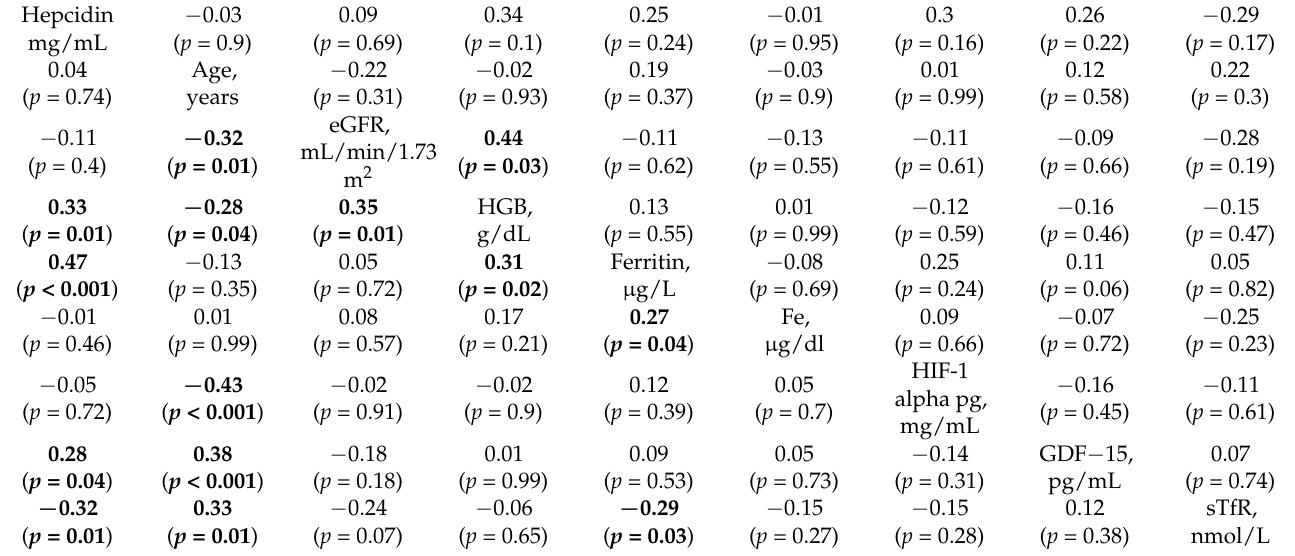
Table 3. Multivariable Pearson correlations between physical